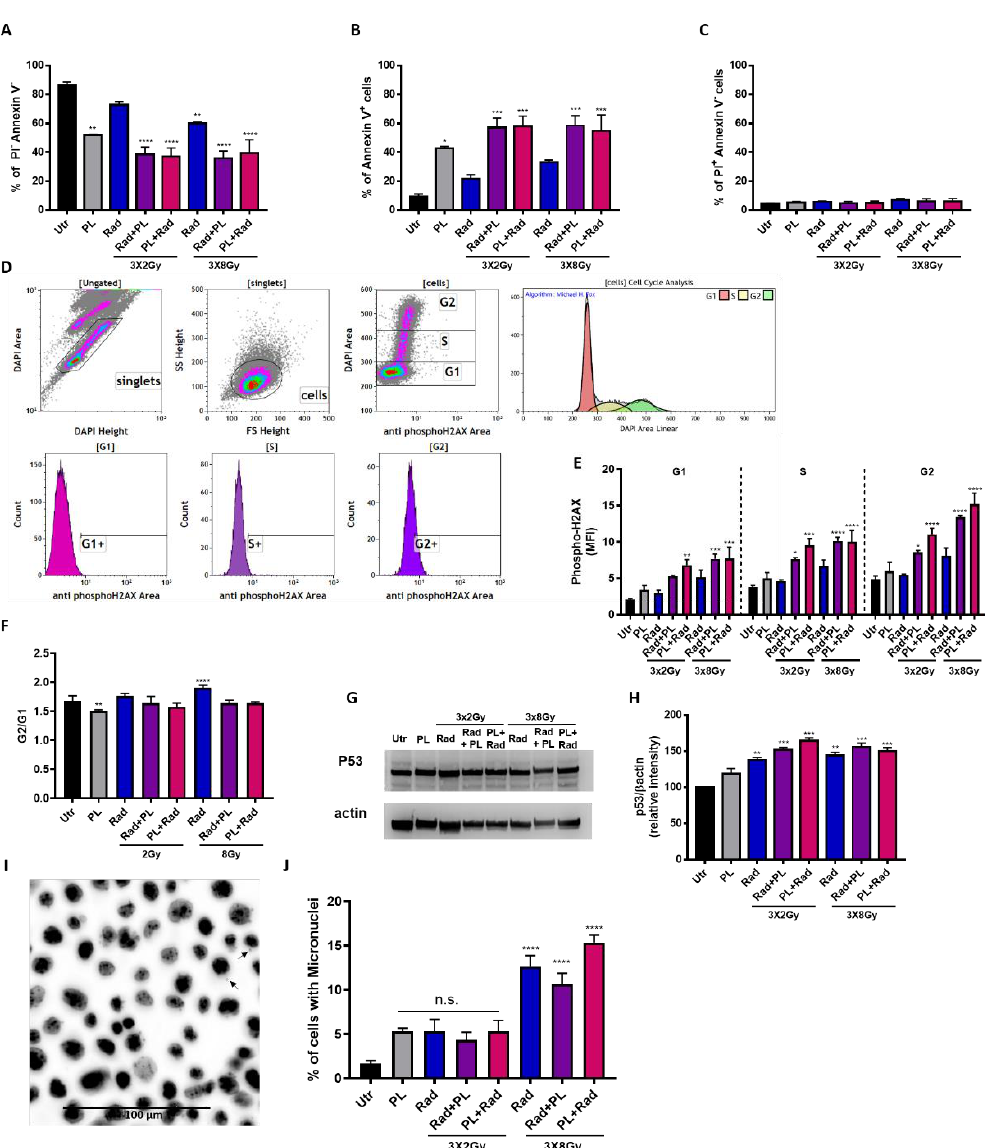
Figure 3. Gas plasma and fractionated radiotherapy conferred toxicity, cell cycle arrest, and p53 upregulation. ( A – C ) B16F10 were exposed to plasma (10 s at 0 h), fractionated radiotherapy (0, 24, and 48 h), or both, and viable ( A ), apoptotic ( B ), and necrotic ( C ) cells were analyzed 24 h after the last radiotherapy cycle (total of 72 h post plasma treatment) by flow cytometry; ( D ) gating strategy to analyze cell cycle arrest and cell cycle-dependent H2AX phosphorylation by first gating singlets and the cells to discriminate G1, S, and G2 cell cycle phase as well as algorithm-driven quantification of the phases; ( E , F ) quantification of phosphorylated H2AX ( E ) and the G2 / G1 ratio ( F ) in B16F10 cells; ( G , H ) p53 and actin Western blots ( G ) and protein quantification against β -actin ( H ) in B16F10 cells; ( I , J ) representative microscopy image ( I ) and determining the percentage of micronuclei in three fields of view ( J ). Data are representative and mean + SE of three ( A – H ) and one ( I , J ) experiment. Statistical analysis was performed by one-way ANOVA. Gy = gray, Utr = untreated, PL = plasma, Rad = radiotherapy, MFI = mean fluorescent intensity, n.s. = not significant; * = p < 0.05, ** = p < 0.01, *** = p < 0.001, **** = p < 0.0001.